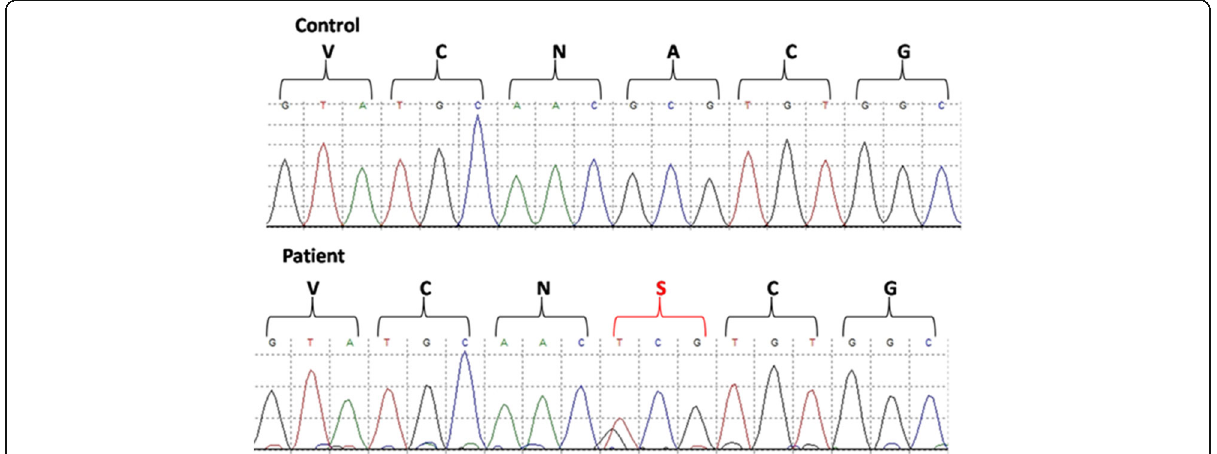
Fig. 4 Electrophoregram showing above the wild-type sequence, and below the heterozygous sequence variant c.2794G > T identified in exon 6 of the TRPS1